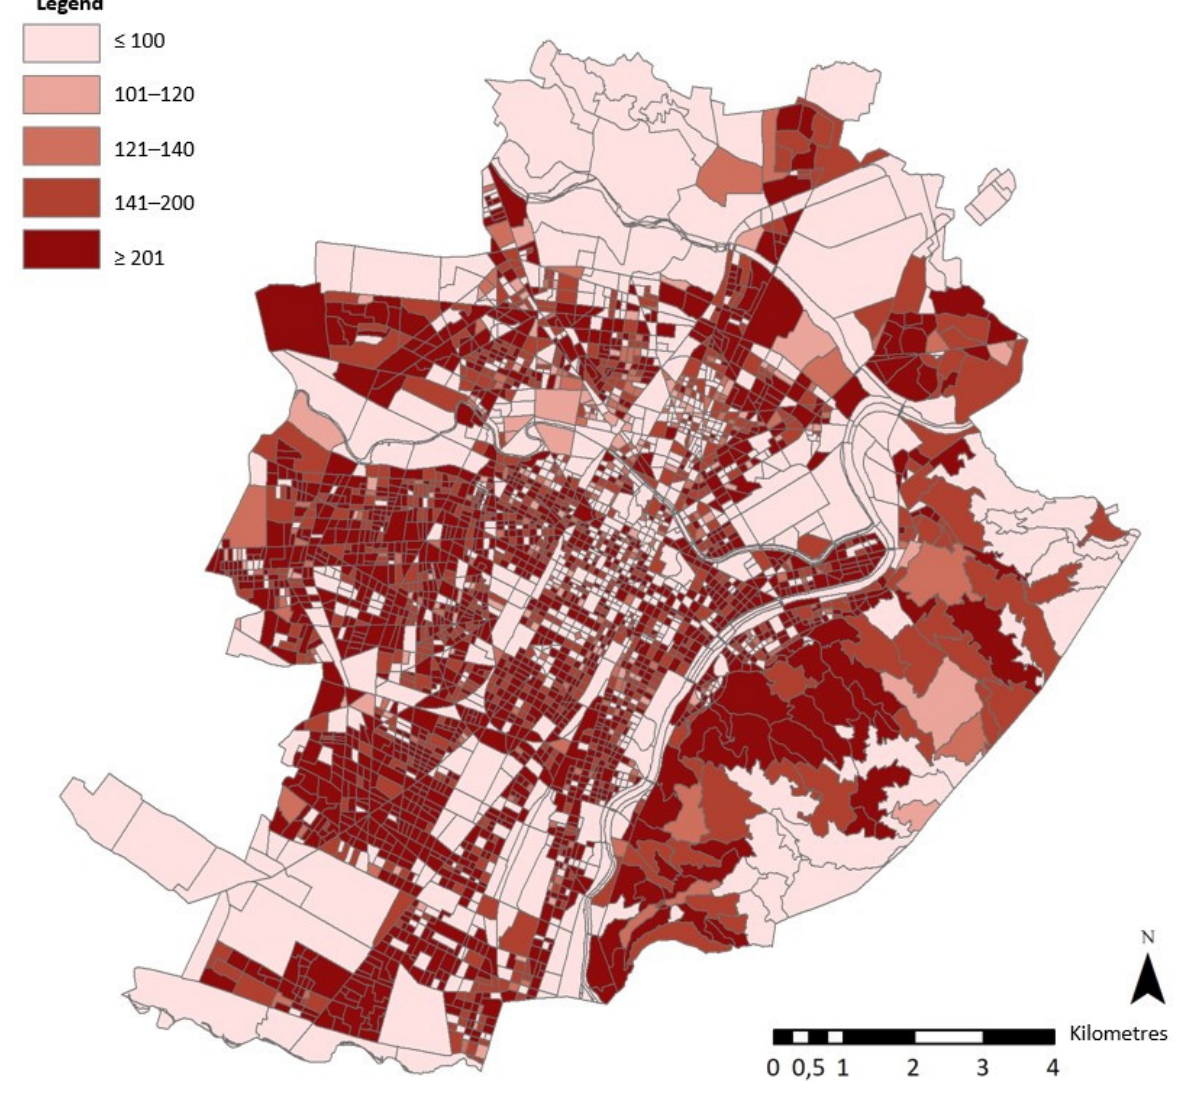
Figure 9. Old age index, year 2020 [29]. Table 7. Old age index for the City of Turin, the Metropolitan City, and the Piedmont Region from 2011 to 2020 [44].